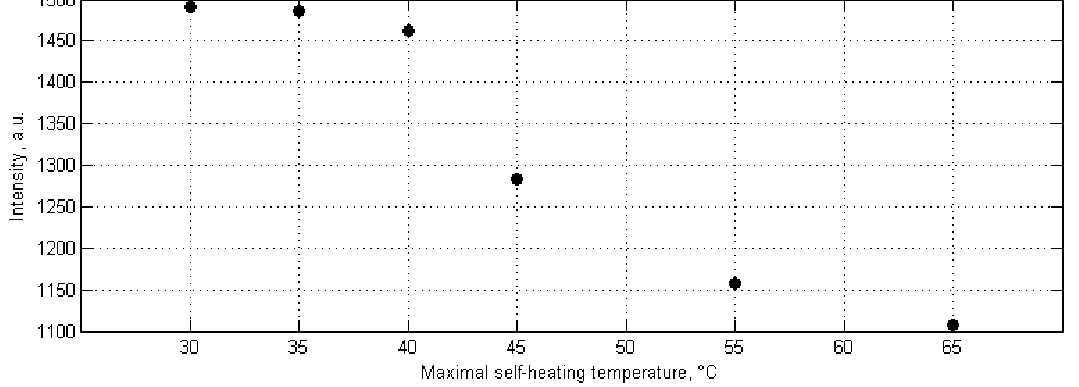
Figure 18. Intensity of Raman epoxy band (1256 cm − 1 ) for various self-heating temperature values.